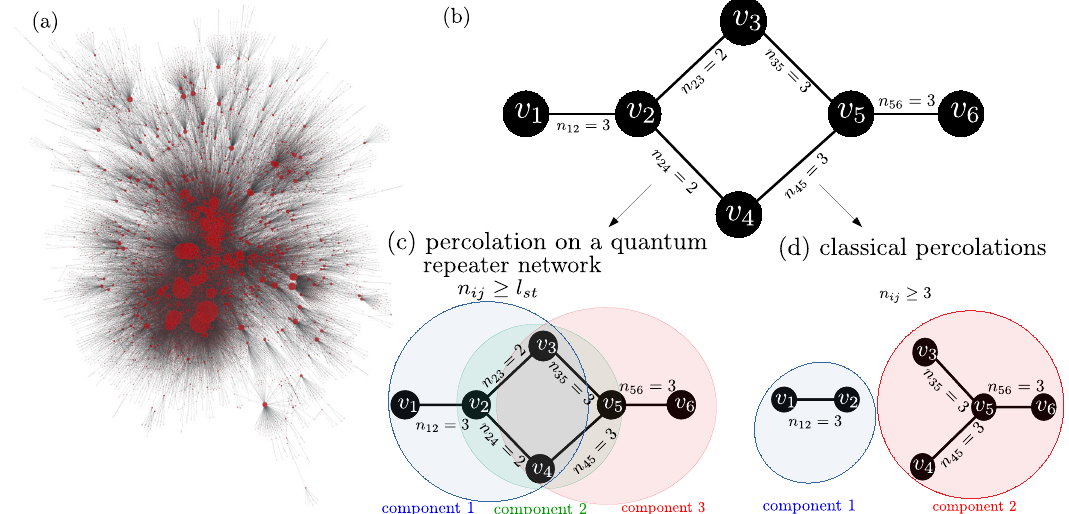
Fig. 1 Complex quantum networks. Depicted in a is a snapshot of the structure of Internet (at the level of autonomous systems using the dataset from 31 ) clearly showing the scale-free properties of this complex network. This snapshot could in principle belong to a future quantum internet 1, 48 which will, however, operate on different network principles. These differences can be seen even at the small scale. In b a small scale quantum-repeater network is shown, indicating how the connected components can intersect each other, in stark contrast to what is observed in a classical network. Here each node is represented by a black dot and the links by black lines. n ij represents the number of entangled pairs associated with each link e ij , which is chosen for this illustration to scale as r ( l ) = l . Two nodes v i and v j are connected at a distance l if there is a path between them such that for all links in that path satisfy the condition n ij ≥ l , with l being the distance between node i and j . In c, d different connected components are displayed by blue green and red circle. c Illustrates a quantum network where one can only connect two nodes if n ij ≥ l . The connected components clearly intersect each other. In contrast d illustrates a classical network where links can only be used to connect two nodes if n ij ≥ 3. In this case the connected components do not intersect each